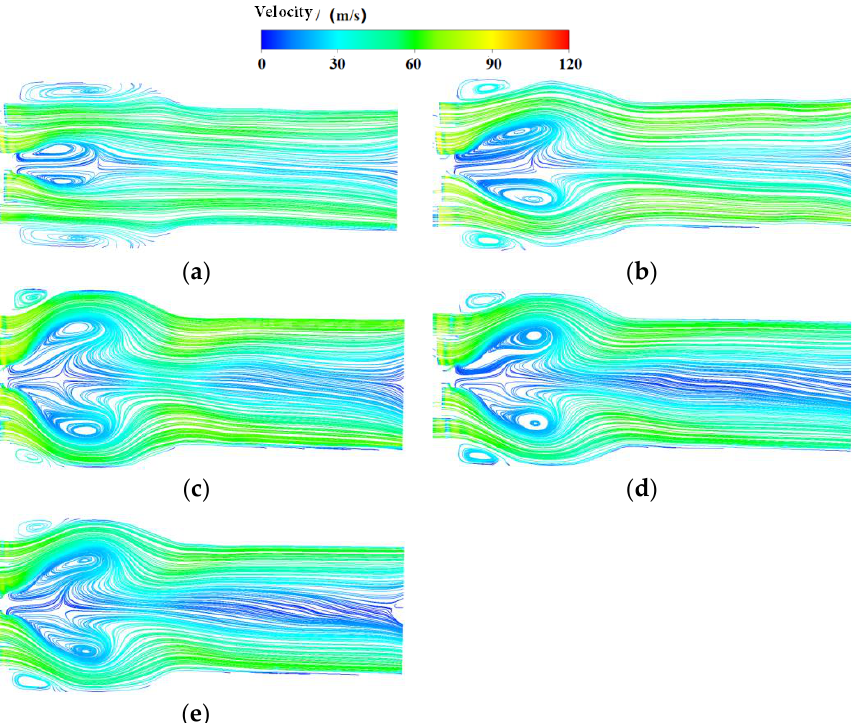
Figure 5. Flow characteristic time-averaged with different Sn. ( a ) case 1, θ = 30°, n = 22, Sn =0.752; ( b ) case 2, θ = 45°, n = 22, Sn = 0.836; ( c ) case 3, θ = 60°, n = 22, Sn = 1.127; ( d ) case 4, θ = 60°, n = 16, Sn = 0.846; ( e ) case 5, θ = 60°, n = 28, Sn = 1.362.